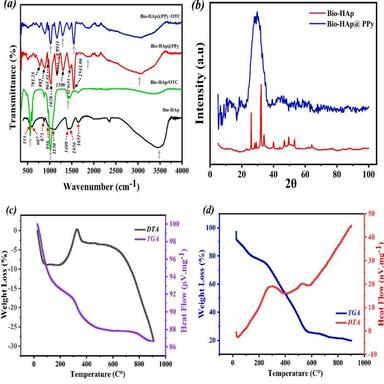
(a) FTIR spectra of Bio-HAp and Bio-HAp@PPy nanocomposite before and after adsorption; (b) XRD analysis for Bio-HAp and Bio-HAp@PPy nanocomposite; (c) TGA/DTA analysis of Bio-HAp; (d) TGA/DTA analysis of Bio-HAp@PPy nanocomposite.